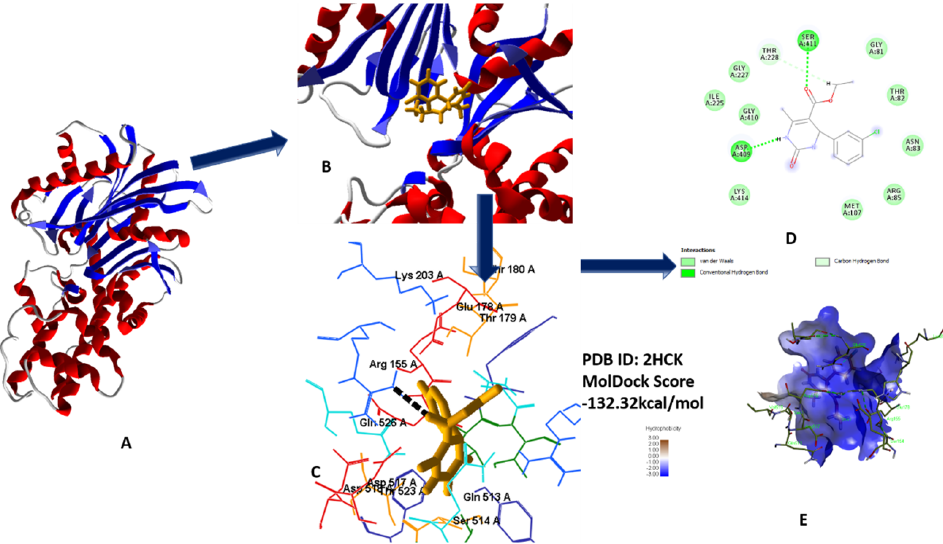
Figure 10. ( A ) Secondary structure of 2HCK; ( B ) secondary structure along with lead compound 5c ; ( C ) 3D interaction with protein; ( D ) 2D diagram; ( E ) hydrophobic interaction of 5c with 2HCK.